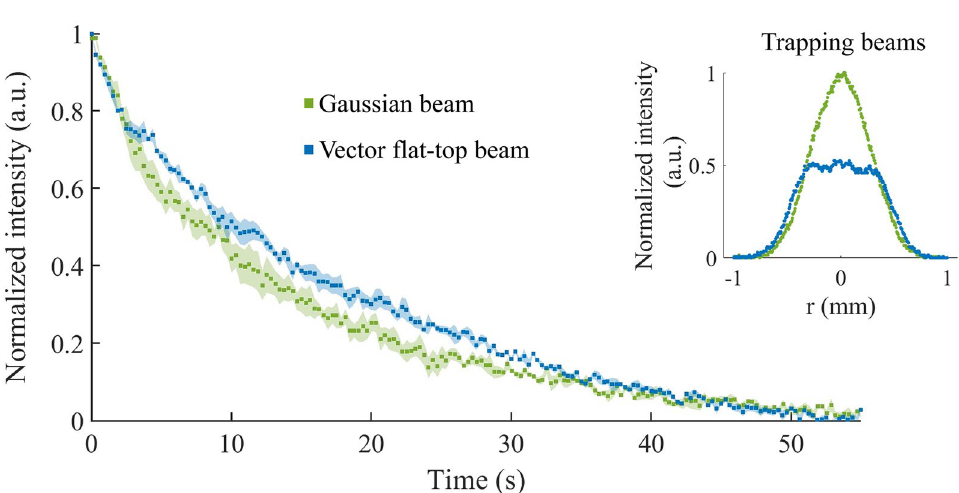
Figure 8. The average photobleaching of three trapped QD-tagged beads in a Gaussian and flat-top beam trap at a trapping power of 60 µ W (the shaded area represents the standard error). Longer photobleaching lifetimes were observed for the fluorophores in the flat-top beam trap as compared to the Gaussian beam trap. The inset shows the experimental profiles of the trapping